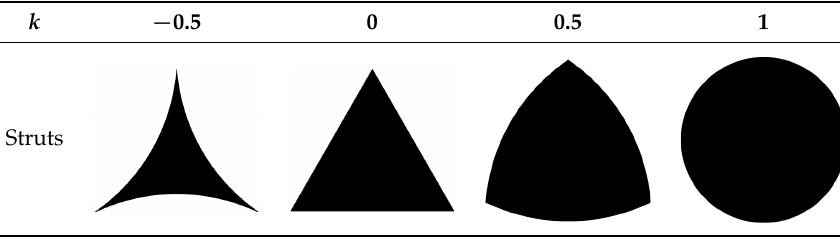
Table 2. Illustration of the cross sections with different normalized curvatures.